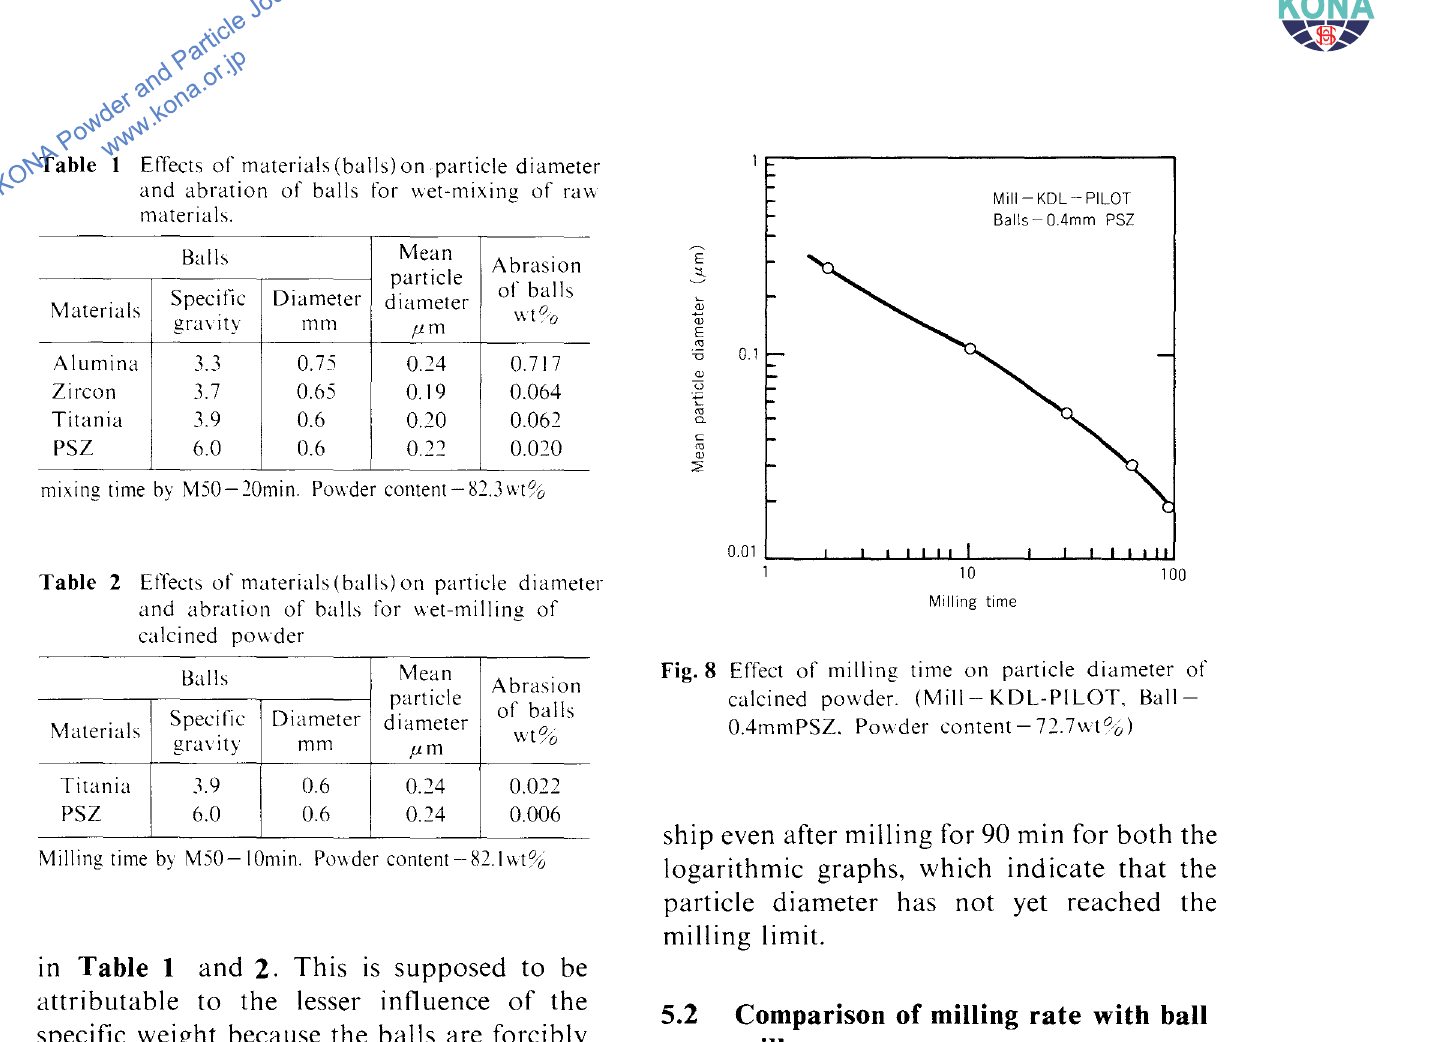
Fig. 8 Effect of milling time on particle diameter of calcined powder. (Mill- KDL-PILOT. Ball-